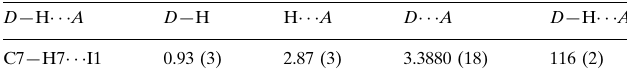
Data collection Bruker SMART APEXII CCD area-detector diffractometer Absorption correction: multi-scan ( SADABS ; Bruker, 2005)